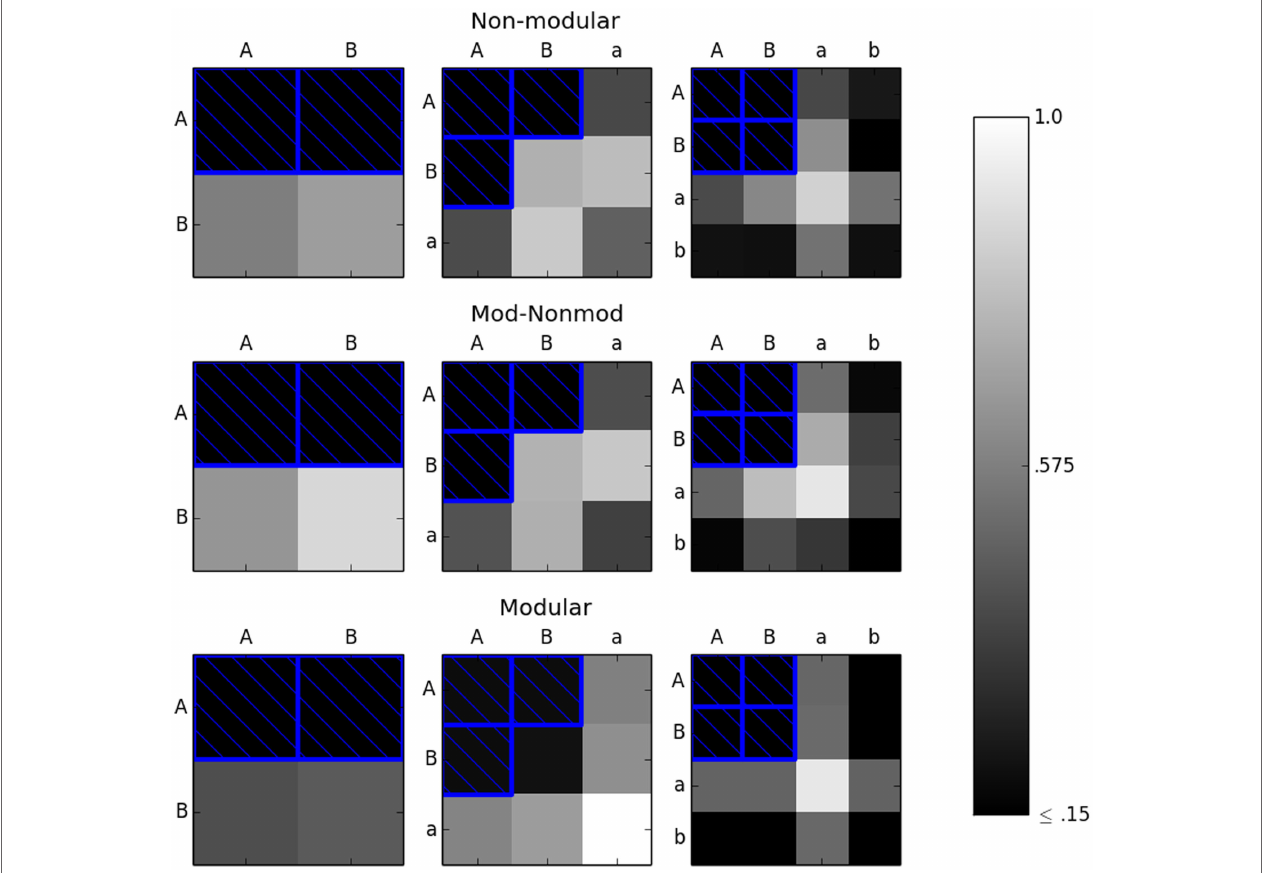
FIGURE 7 | The M (bottom row), MNM (middle row), and NM (top row) robots were evolved in the corners (environments with blue boxes around them) until they achieved an error of less than or equal to 0.15 in each environment in the subset considered . The robots were then tested in the remaining environments. The color of the box of each environment represents the average reported error in that environment. Here, we see that it is necessary to use completely independent subsets of environment to ensure linear scaling in the modular case.